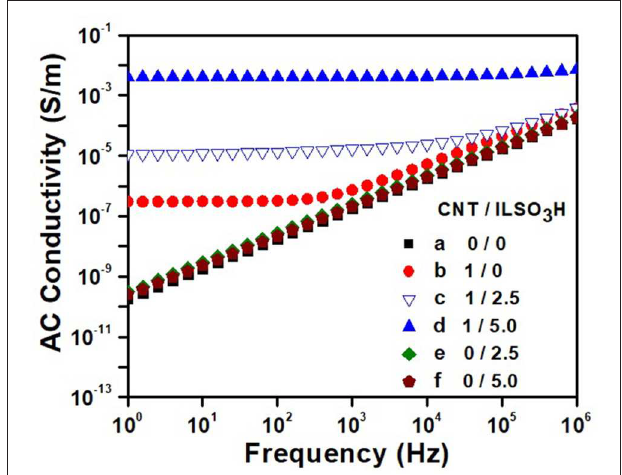
FIGURE 8 | AC electrical conductivity against frequency for PLA/EVA blends and composites containing CNT/ILSO 3 H in a proportion of (a) 0:0; (b) 1:0;